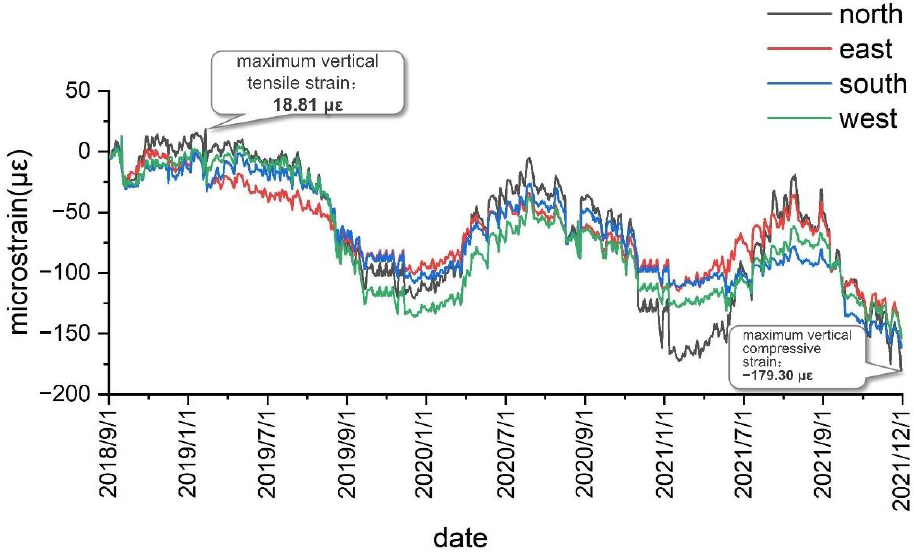
Figure 13. Measured vertical strain curves at second monitoring level.